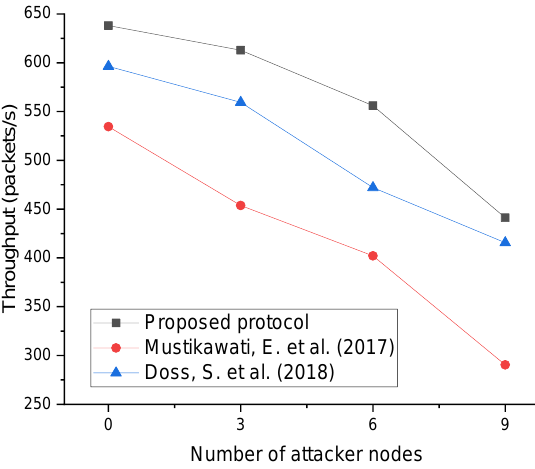
Figure 18. Nodes’ data throughput under Jellyfish reordering attacks Figure 18. Node s’ data throughput under Jellyfish reordering attacks [20, 37].